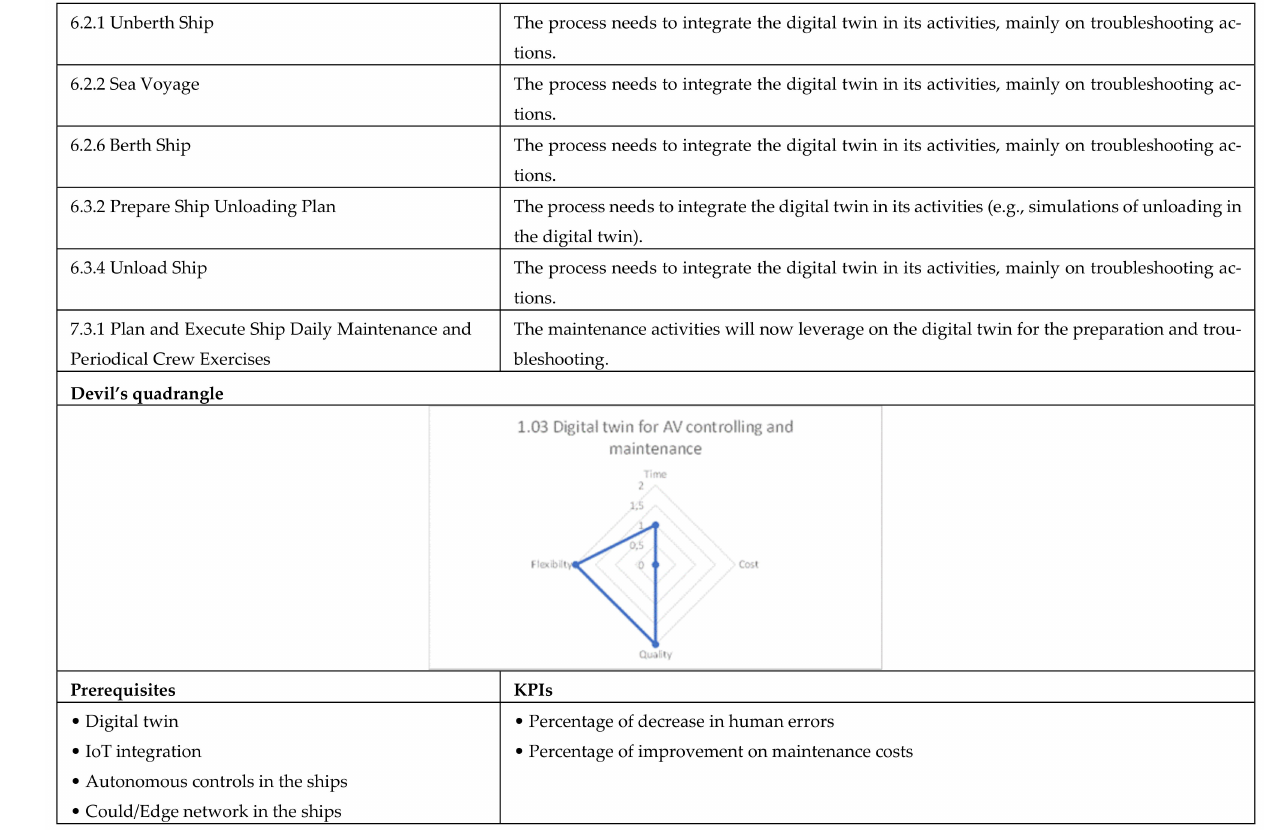
Figure A3. Digital twin for AV controlling and maintenance data sheet.